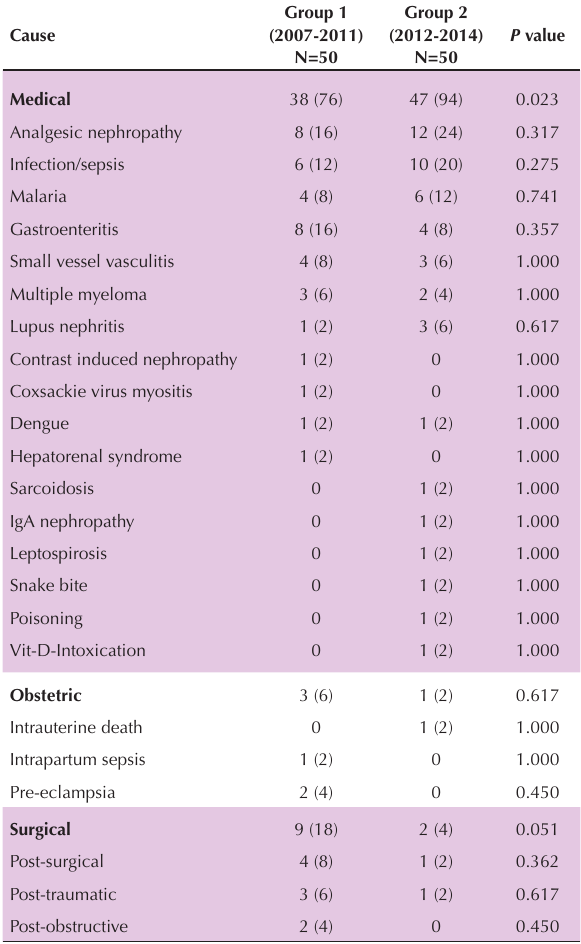
Table 2. Summary of causes